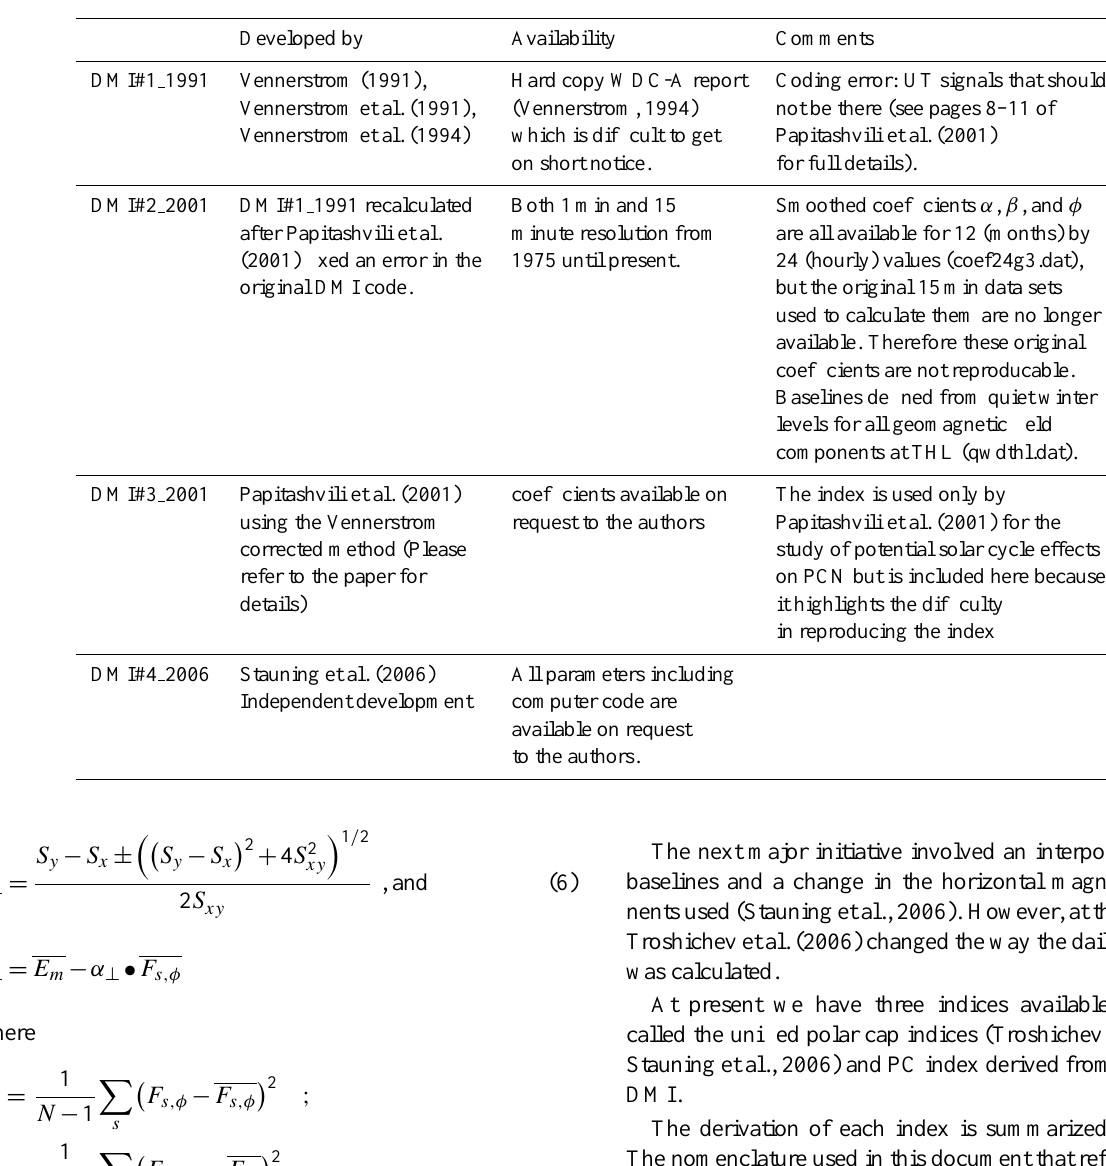
Table 2. Characteristics of the PCN